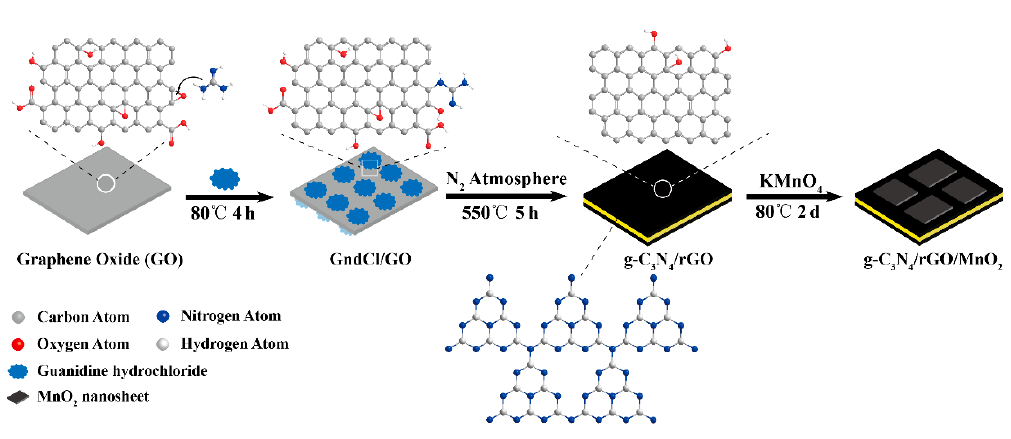
3 N 4 /rGO/MnO 2 ternary nanocomposite.